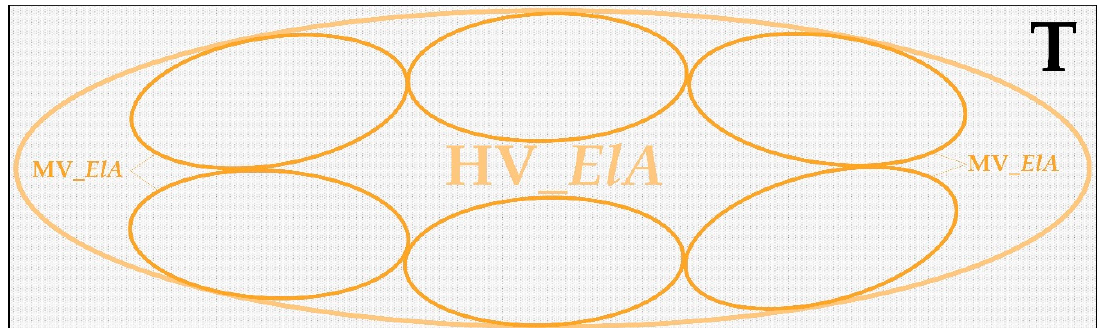
Figure 4. Overview of the structure of smart grids: ( a ) Real conditions; ( b ) fractal.